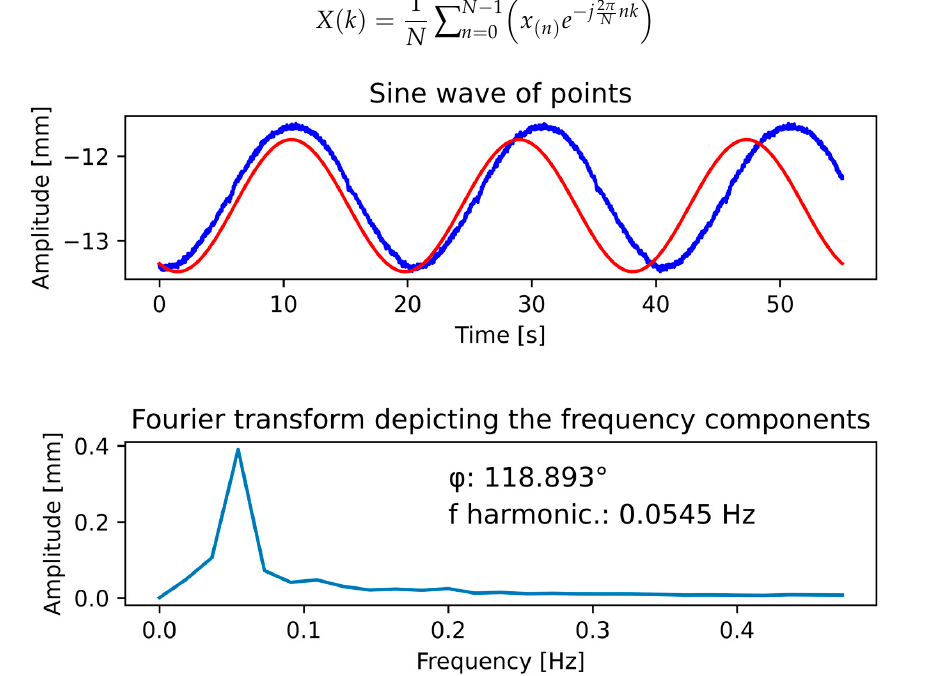
Figure 8. Fourier transform according to eccentricity sinusoidal wave; above: blue— z line in plane XY corresponding to amplitude and time, red—computed sinusoidal wave based on Fourier transform; below: plot of harmonic frequencies and their amplitudes.